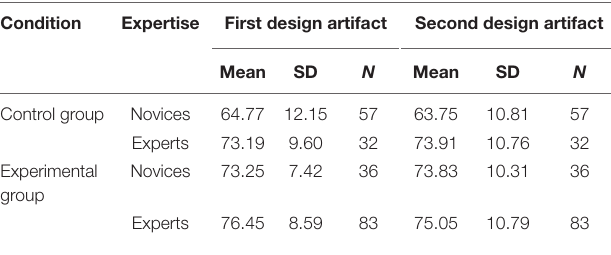
TABLE 3 | Descriptive statistics of pre-service teachers’ total TPCK competency.